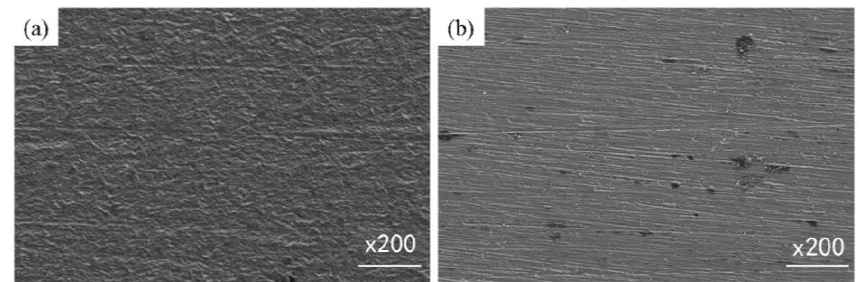
Figure 5. The immersion experiments of the samples. Figure 6. Surface morphology after soaking in weak alkaline solution for 20 days: ( a ) TD film ( b ) TTTD film.